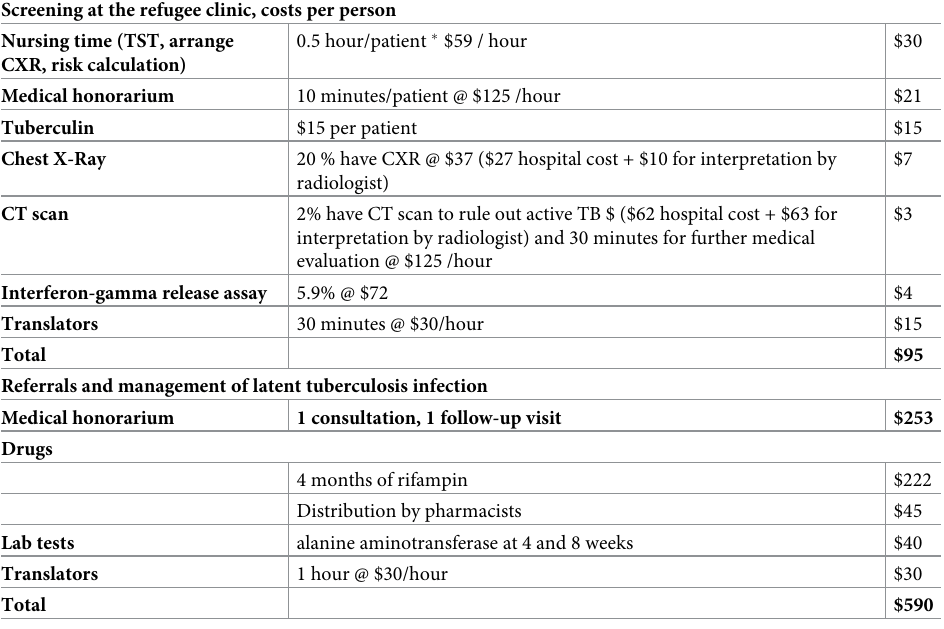
Table 5. Costs of identification and management of latent tuberculosis infection (in 2020 Canadian dollars). Screening at the refugee clinic, costs per